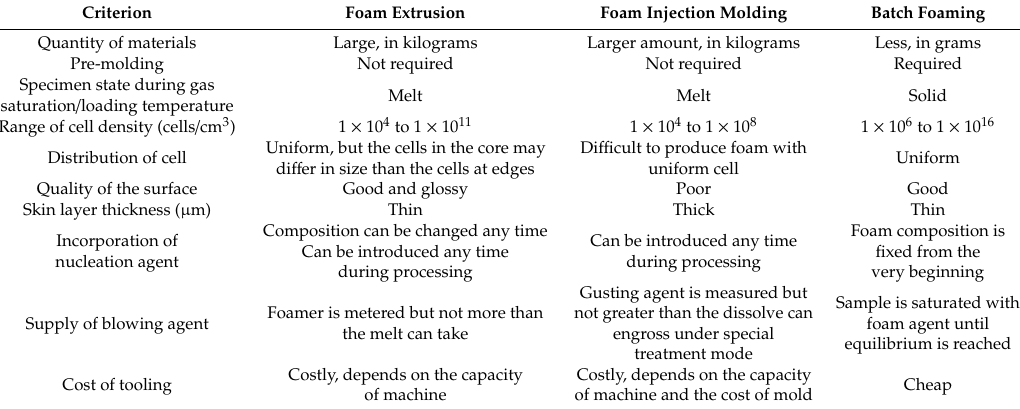
Table 3. Comparison on foam extrusion, batch foaming, and foam injection moulding